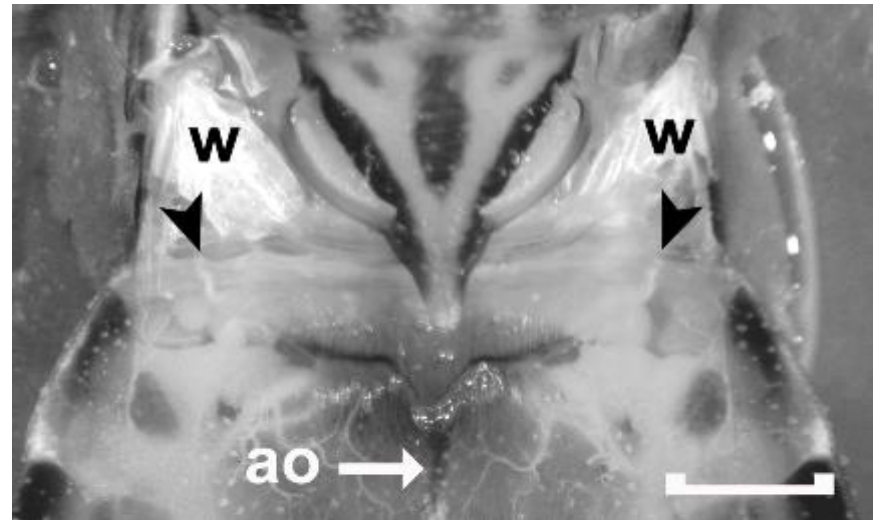
Figure 3. Dorsal view of the metathorax and the first full-sized abdominal segment (Segment 1 (cid:177) 2) of an adult male Rhodnius prolixus covered with Rhodnius saline to increase the transparency of the cuticle. Wings have been removed leaving only their bases attached (w). Black arrowheads point to the first set of abdominal spiracles that are located on the dorsal side of the animal. The spiracles are not visible, but their corresponding tracheal trunks can be viewed through the transparent cuticle. The aorta of the dorsal vessel (ao) can also be seen through the cuticle. Scale bar: 1